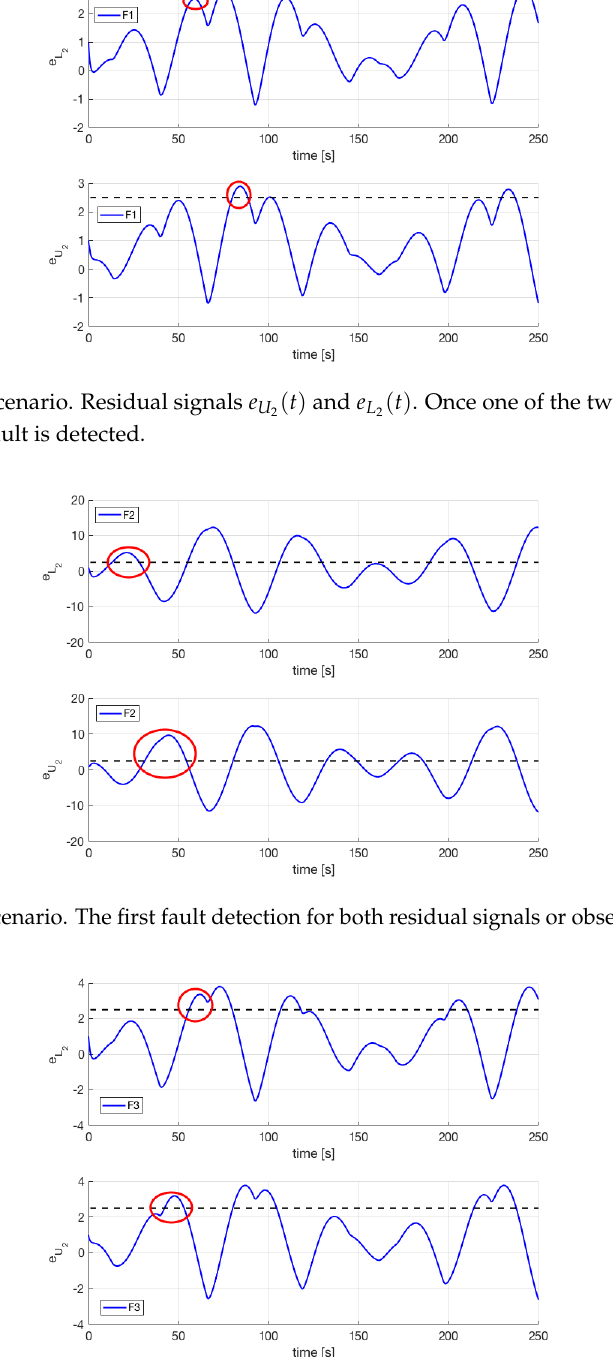
allows for detecting a fault faster than e L 2